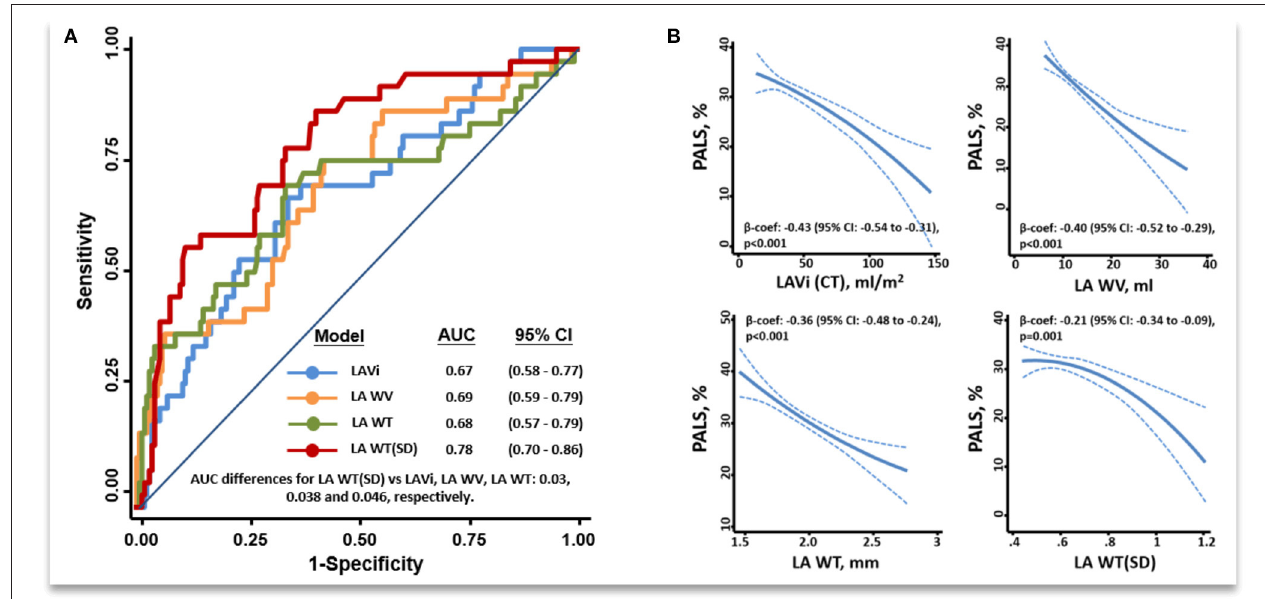
FIGURE 2 | ROC among all LA wall indices in discriminating isolated AF from control and HFpEF after excluding patients with both HFpEF and AF (final n = 211) (A) . Fitting curves showing inverse associations between a greater unfavorable remodeling of the various MDCT LA wall indices and PALS (B) . ROC, receiver operating characteristic curve; PALS, Peak atrial longitudinal strain; other abbreviations as Figure 1 .